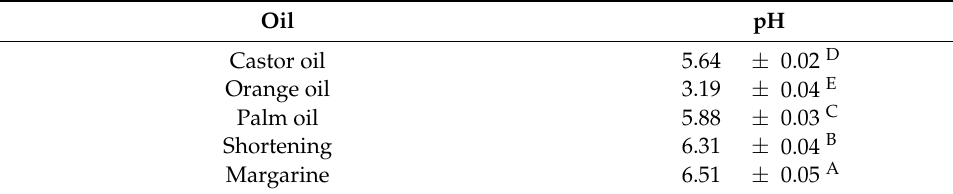
Table 9. pH values of vegetable oils used to prepare meat